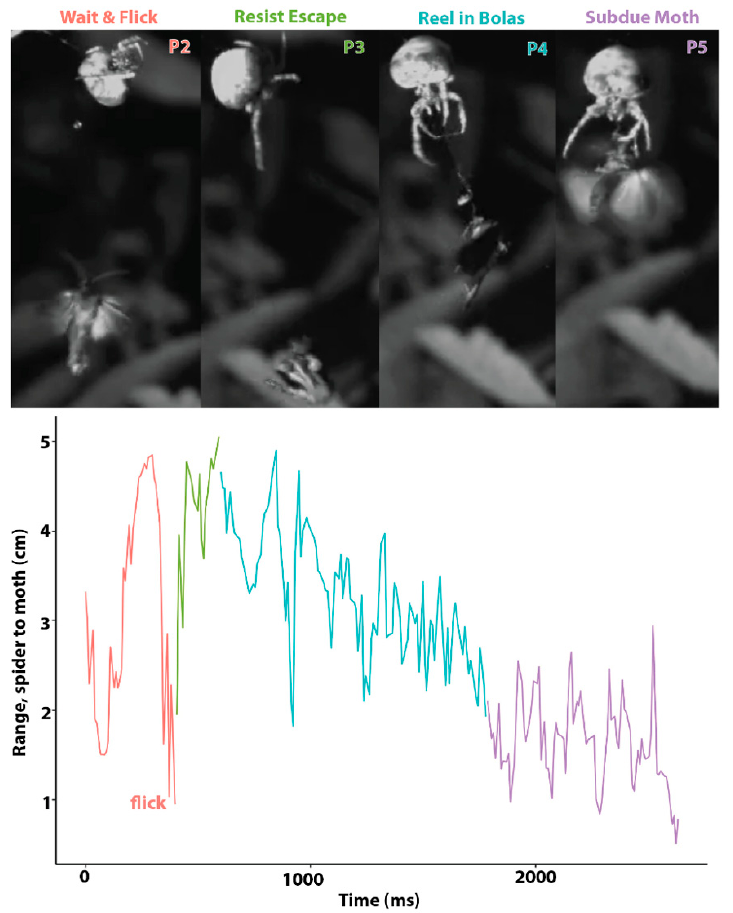
Figure 3. Bolas spider capturing a moth by flicking its bolas. In four of five successful capturing events, the spider and moth interacted in five phases, four of which are shown here ( top ). The distance between the spider and the moth, denoted as range ( bottom ), quantifies the dynamics of the struggle, with the colors of the lines corresponding to the phases above.